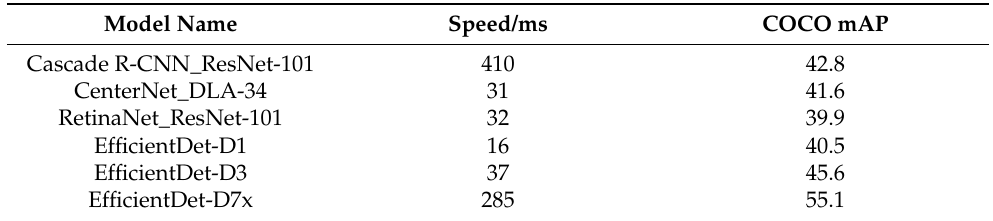
Table 1. COCO-trained partial